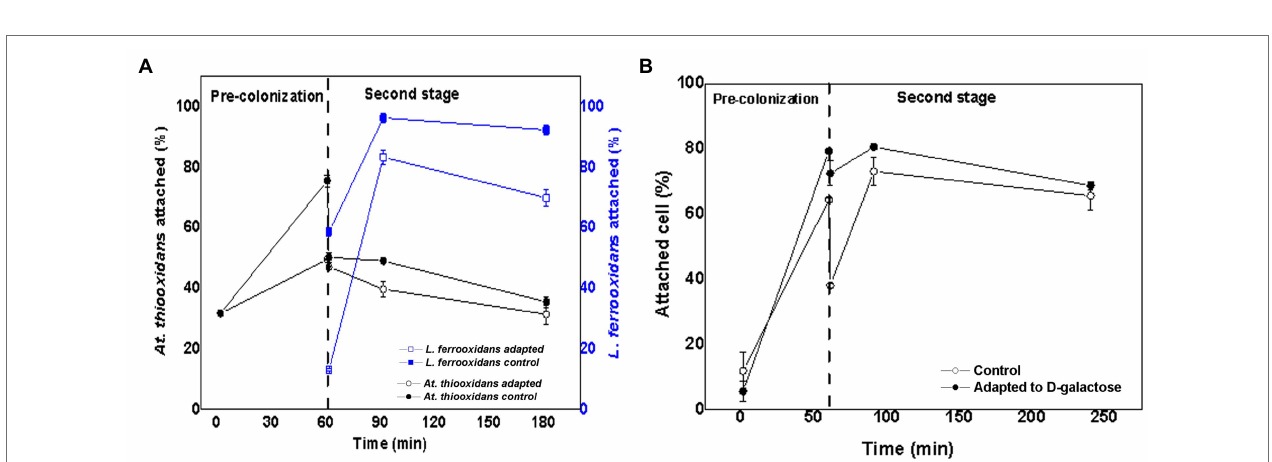
FIGURE 6 | Attachment percentage to the mineral over time of L. ferrooxidans DSM 2705 T and At. thiooxidans DSM 2705 T using At. thiooxidans DSM 2705 T as a pre-colonizer. (A) Data obtained by qPCR. (B) Data obtained by counting total planktonic cells using a Neubauer chamber. Measurements after 1, 60, 61, 91, and 181 min of inoculation of the first species. The data correspond to the mean values of triplicates ± SD ( n =